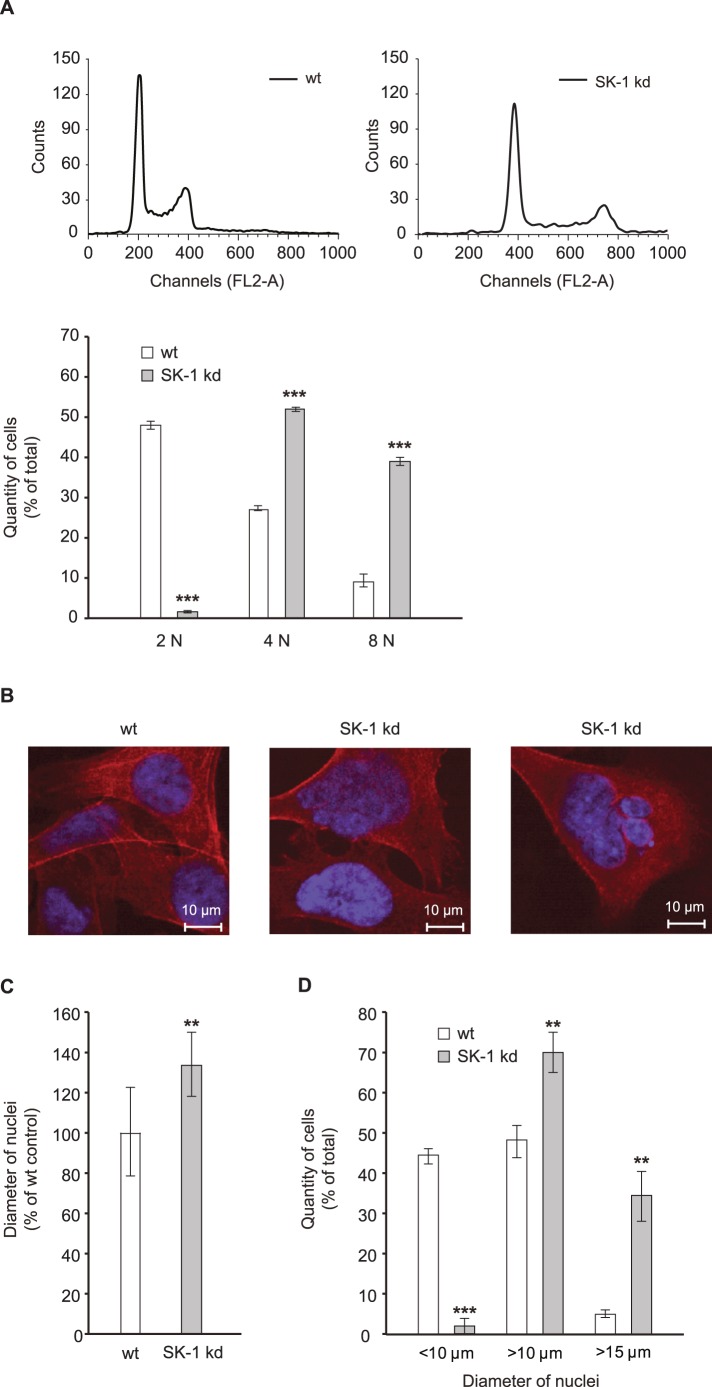
Downregulation of SK-1 induces endoreduplication.(A) MDA-MB-231 wt cells and SK-1 kd cells were stained with propidium iodide and DNA content was measured by flow cytometry using a FACSCalibur flow cytometer and the Cell Quest software for data processing. (B) confocal microscopy of MDA-MB-231 wt and SK-1 kd cells upon actin (red) and nuclear staining (blue) using TRITC-labeled phalloidin (dilution 1∶1000) and DAPI, respectively. (C) calculation of the nuclear size of SK-1 kd cells relative to wt cells. (D) quantification of cells with nuclei in different size ranges (<10 µM, >10 µM, >15 µM). Data are means ± SD of three independent experiments; **p<0.01, ***p<0.001 compared to MDA-MB-231 wt cells values.